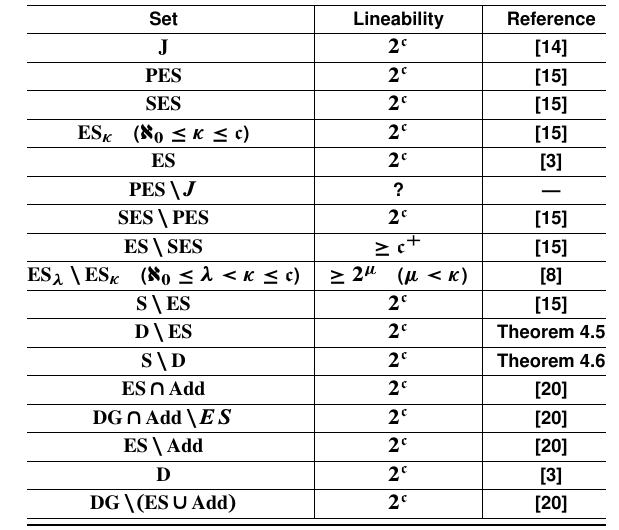
Table 1. Summary of the most important lineability results related to surjective